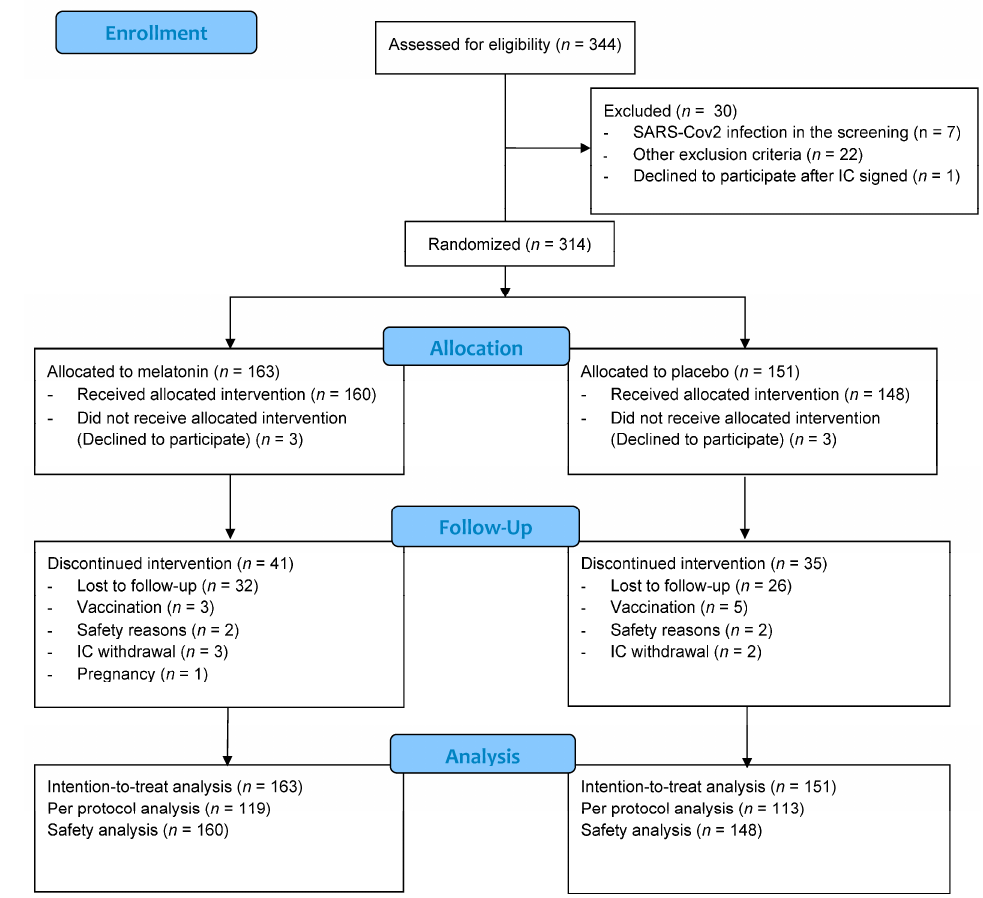
Figure 1. Flowchart of participants included. IC: Informed consent.